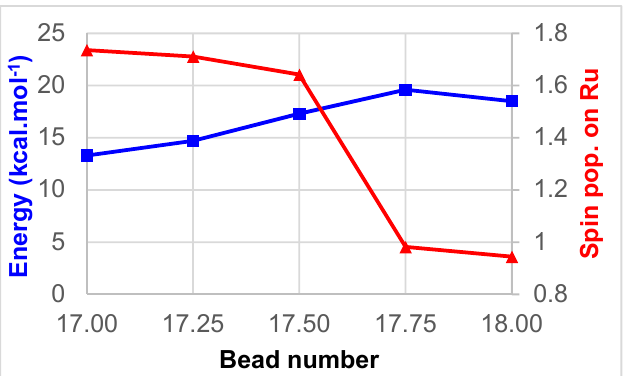
Figure 3. Minimum energy path (blue) and Mulliken spin population on Ru (red) between beads 17 and 18 of the reaction path.